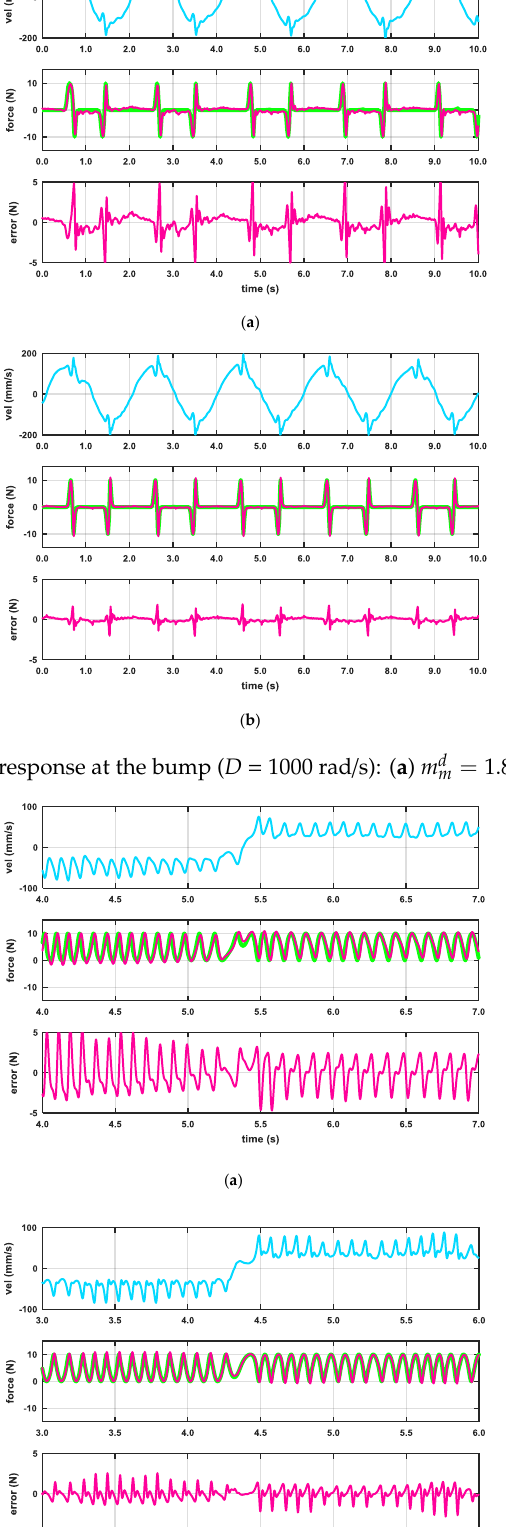
Figure 15. The control response at the graininess ( D =1000 rad/s): ( a